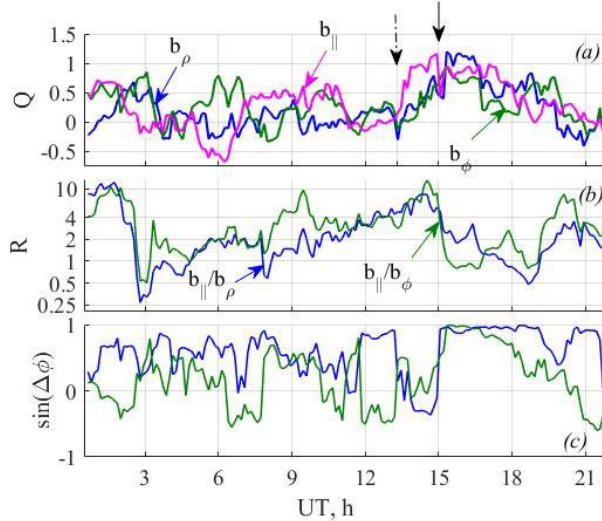
Figure 8. Time variations in (a) the parameter Q , (b) the spec- tral field-aligned to transversal components’ spectral power ratio R , and (c) the sinus of phase difference at Cluster 3. The change in pulsation regime in the IMF (at 13:30UT) and in b || at Cluster at 15:00UT is marked by the arrows, similar to Fig.